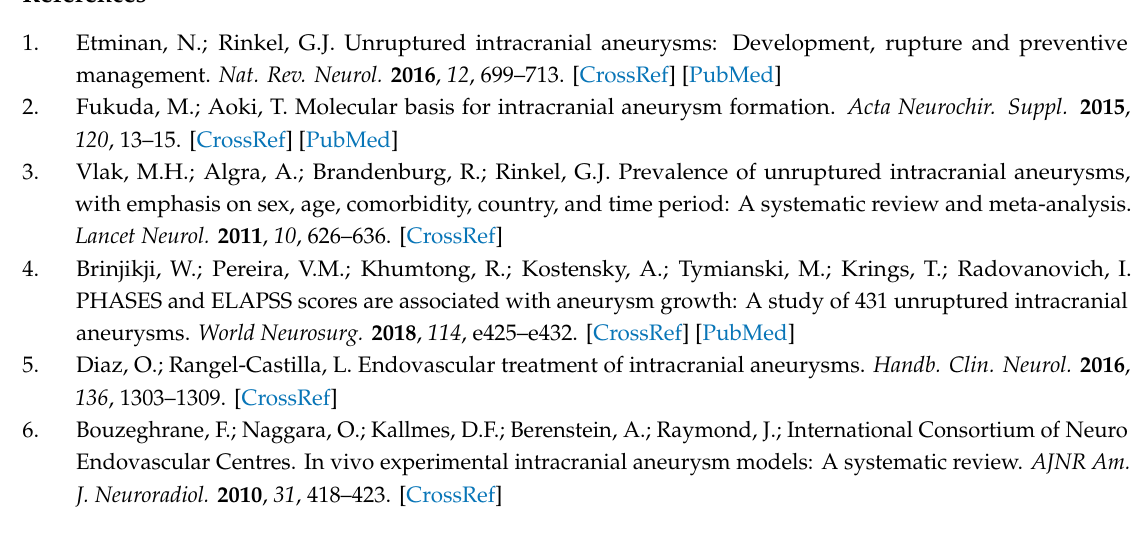
Table S1: Incidence of Aneurysm